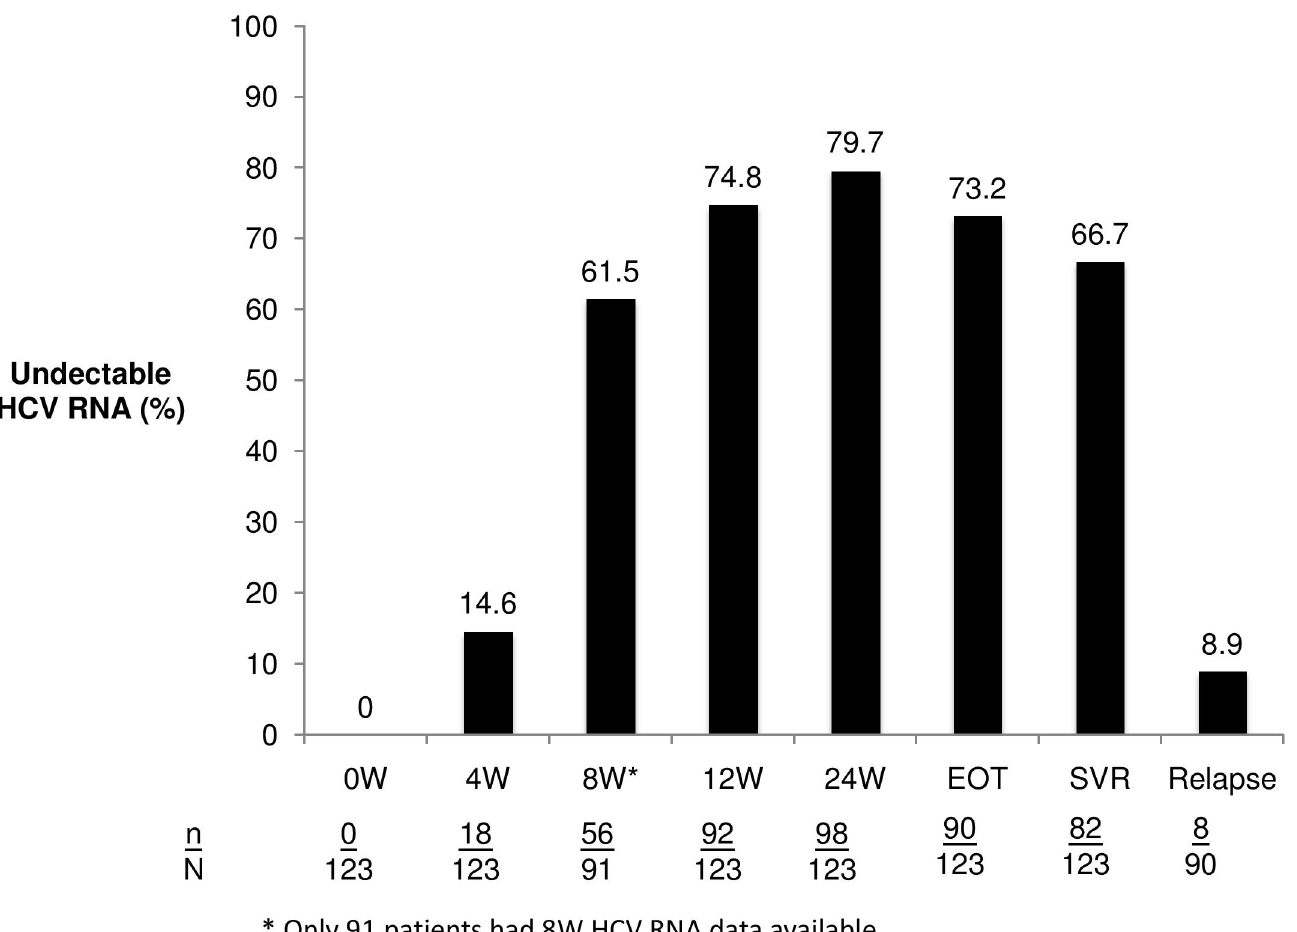
Fig 2. Treatment